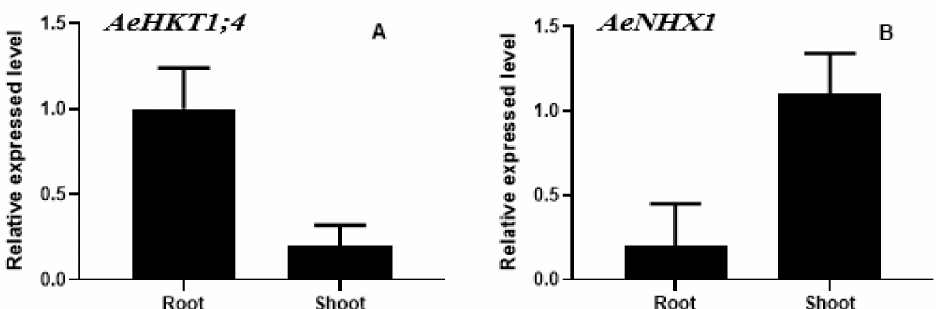
Figure 4. Relative expression levels of AeHKT1;4 ( A ) and AeNHX1 ( B ) in roots and shoots of Ae. tauschii under control conditions. Actin was used as an internal reference. Experiments were repeated three times. Values are means, and bars indicate standard deviations